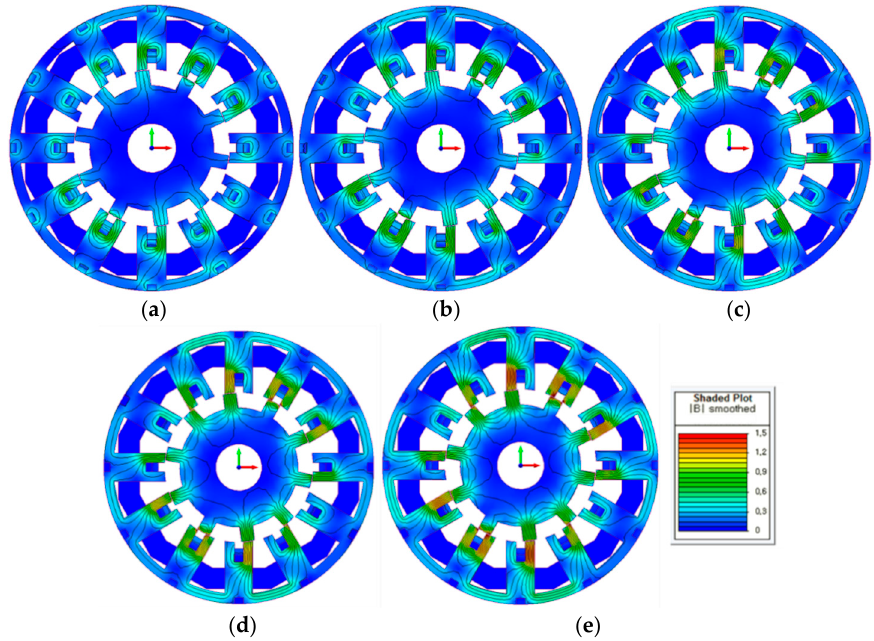
Figure 17. Flux vector contour and magnetic field distribution according to the magneto-motive force (MMF) of the additional field winding: ( a ) − 4 kA · T, ( b ) − 2 kA · T, ( c ) 0 kA · T, ( d ) 2 kA · T, and ( e ) 4 kA ·